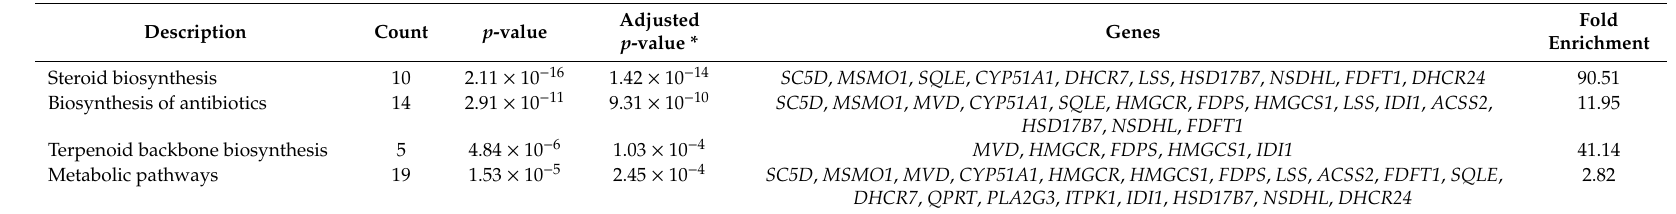
Table 3. Kyoto Encyclopedia of Genes and Genomes (KEGG) pathway analysis of the significantly di ff erentially expressed genes in idiopathic pulmonary fibrosis (IPF) fibroblasts treated with epigallocatechin gallate